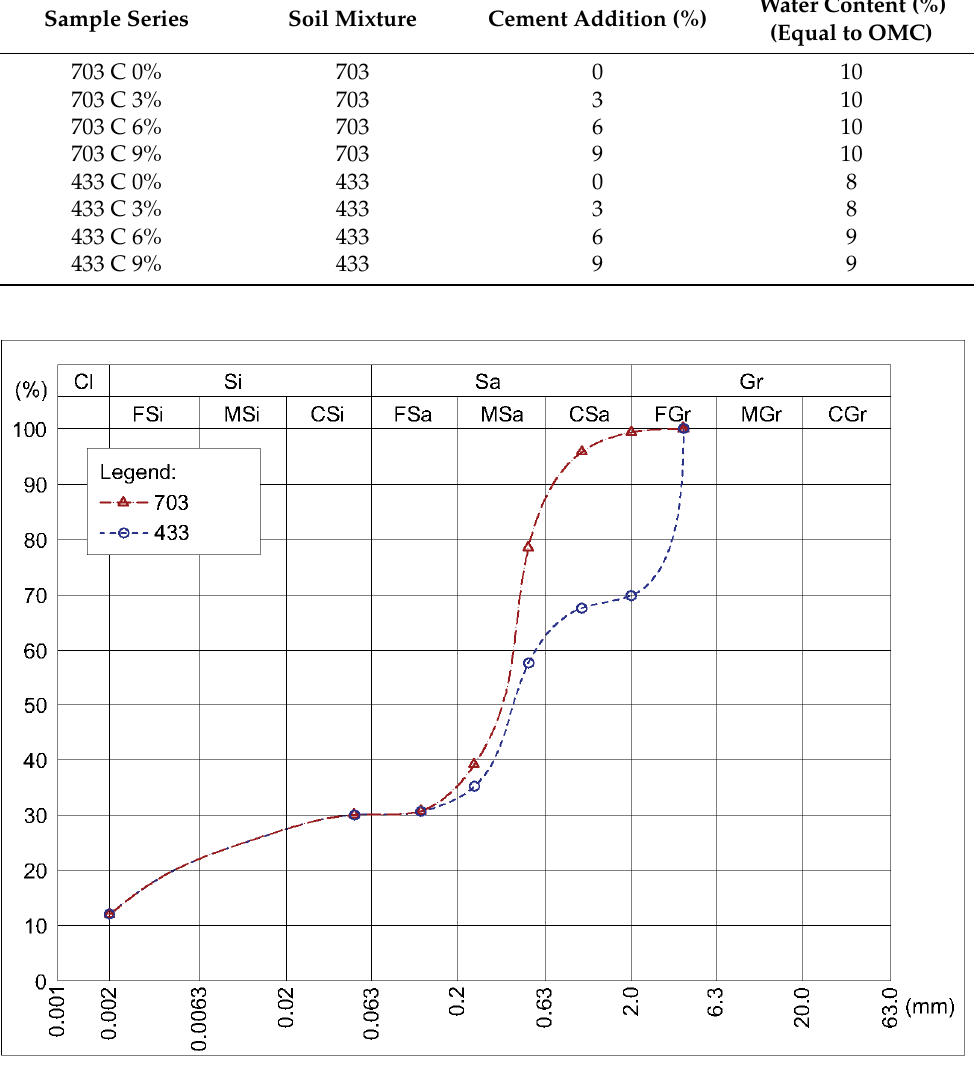
Figure 4. Particle size distribution of soil mixtures used in tests.